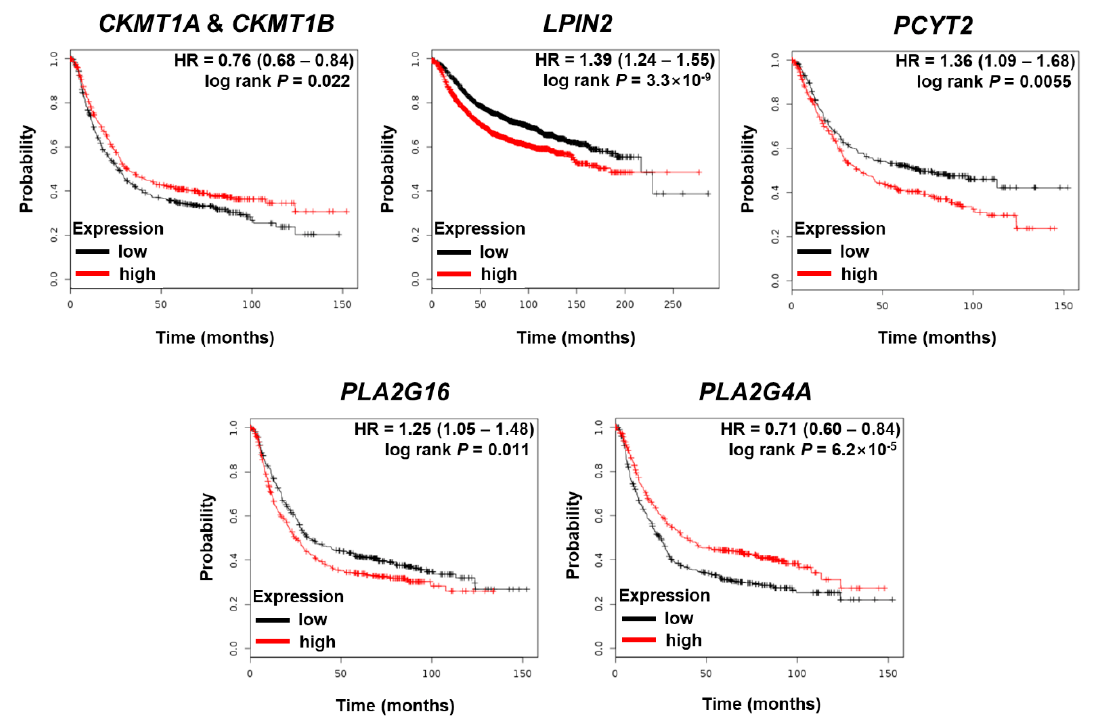
Figure 2. Kaplan–Meier (KM) plots show the effects of the significantly downregulated metabolic genes found in our study. These genes are associated with amino acid and lipid metabolism. HR: hazard ratio.